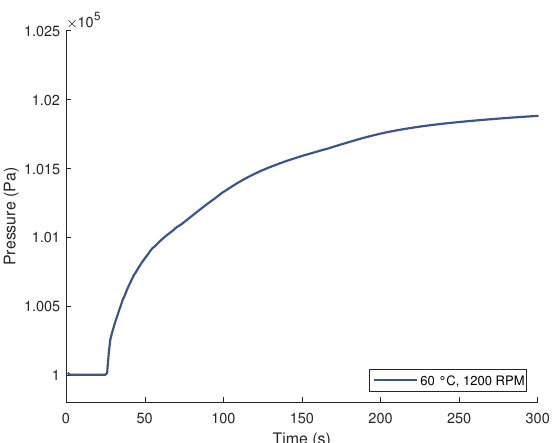
Figure 15. Simulated pressure curve at the position of the sensor after starting the rotation.